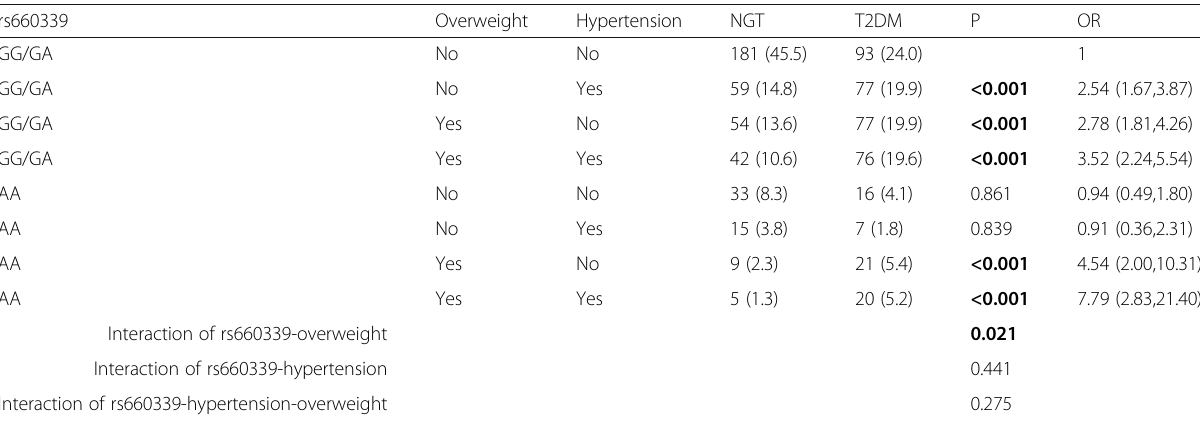
Table 5 Interaction analysis for rs660339 and hypertension and overweight on T2DM